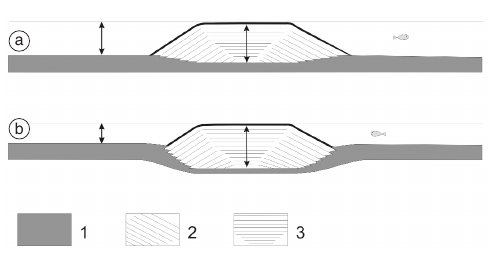
Fig. 9a,b. Regional (a) and local (b) subsidence of a carbonate platform (Bosellini, 1984). In the former case, the water depth of the basin roughly corre- sponds to the thickness of the carbonate platform. In the latter case, with a similar amount of aggradation, the adjacent basin is much shallower. 1: deep-water deposits; 2: platform slope deposits; 3: internal plat- form deposits.